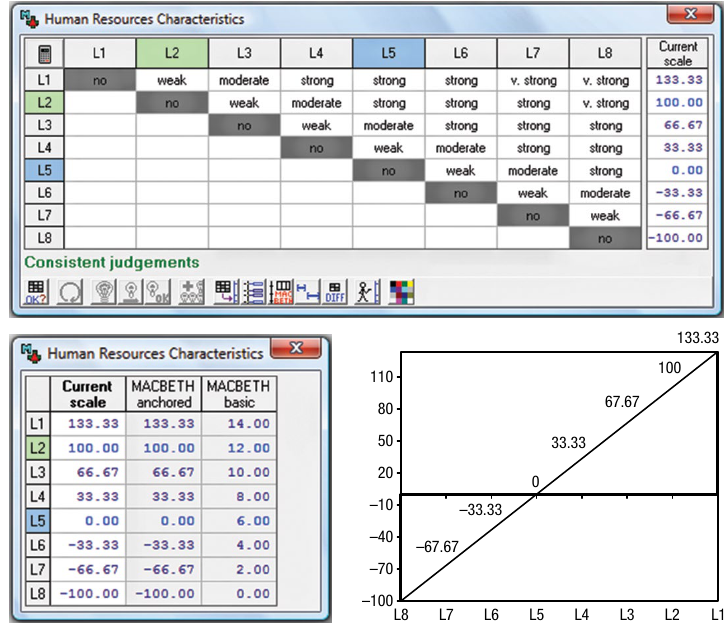
Fig. 6. Value judgements, proposed scales and value function for CRT